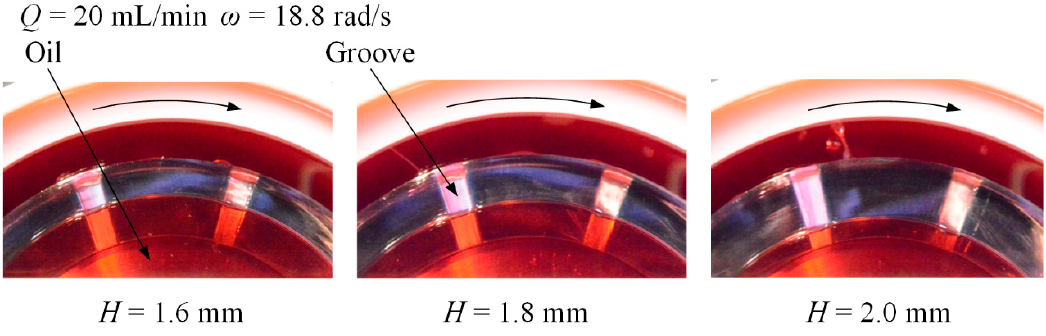
Figure 11. Comparison of the air–oil interface radial position with different disk spacing.